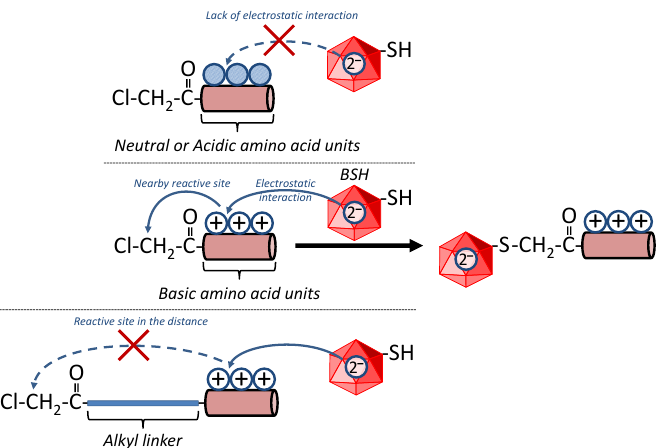
Figure 5. Proposed schematic of the promotion of reactivity of chloroacetyl-modified peptide with BSH by the basic amino acid residue close to the chloroacetyl group. Supplementary Materials: The following are available online at https://www.mdpi.com/article/10.3390/pr10112200/s1,: Figure S1: 1 H NMR spectrum of ClAc-OSu, Figure S2: 13 C NMR spectrum of ClAc-OSu, Figures S3–S26: MALDI-TOF mass spectra of tripeptides, Figures S27–S50: RP-HPLC charts of tripeptides, Figure S51–S74: RP-HPLC charts of reaction mixture of BSH and tripeptide, Figure S75–S84: MALDI-TOF mass spectra of BSH peptides, Figure S85–S94: RP-HPLC charts of BSH